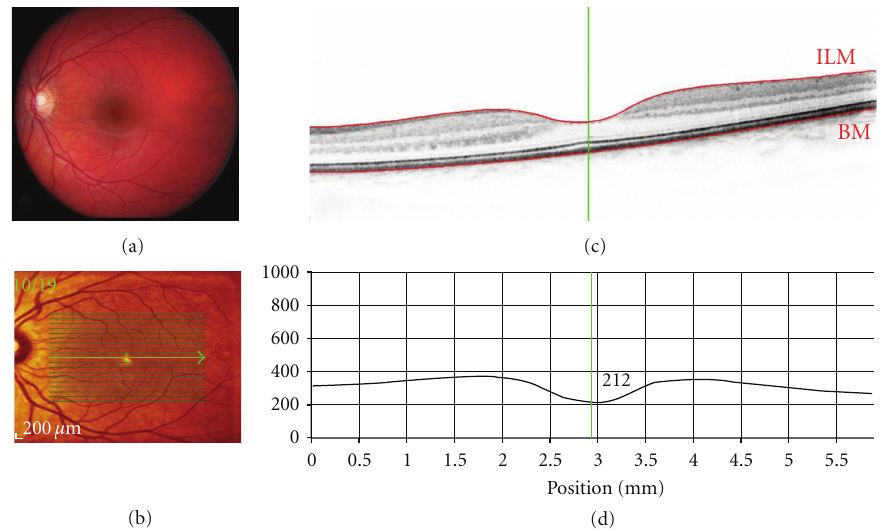
Figure 1: Spectral-domain (SD-OCT) optical coherence tomography of a healthy retina (OS): Scan parameters: infrared scan angle 30 ◦ ; OCT scan angle 20 ◦ ; pattern size 20 ◦ × 15 ◦ , 19 sections (244 µ m between B-scans). (a) Conventional fundus camera image. (b) SD-OCT en- face image showing overlaid OCT scan lines (green) and scan area. The green arrow shows the position of the scan line used to generate the cross-sectional retinal OCT image (i.e., (c)). (c) Cross-sectional image of the retina depicts the vitreous cavity (upper, optically clear area), the internal limiting membrane (segmented by the upper red line marked ILM, the intervening retinal layers, Bruch’s membrane which is segmented by the lower red line marked BM, and the underlying choroid (lower). The vertical green line defines the position of the retinal thickness measure along the cross-sectional retinal thickness profile. (d) Cross-sectional retinal thickness profile corrected for tilt.